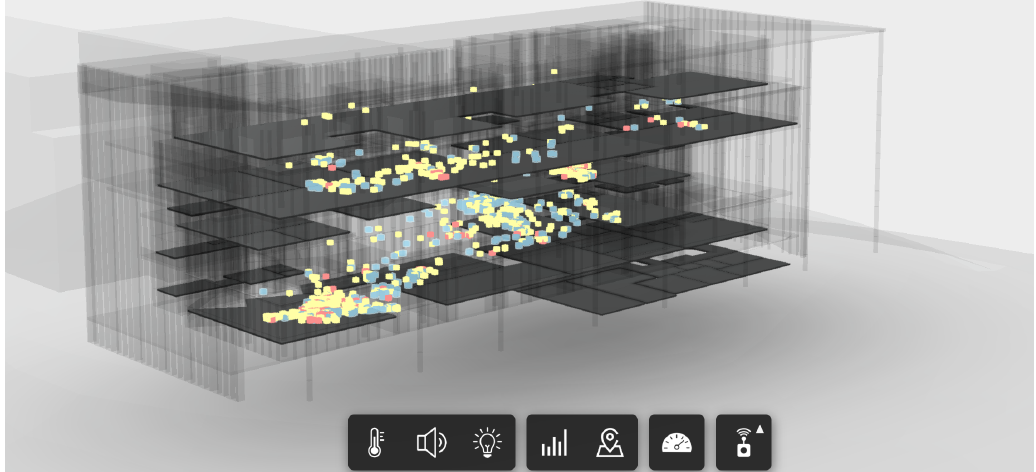
Figure 6. Interactive visualisation of the data collection in the SDE4 building that highlights the spatial distribution of subjective preference data for thermal comfort in three dimensions. In terms of preference feedback, the blue dots indicate prefer-cooler responses, the yellow dots are no change , and the red dots are prefer-warmer .